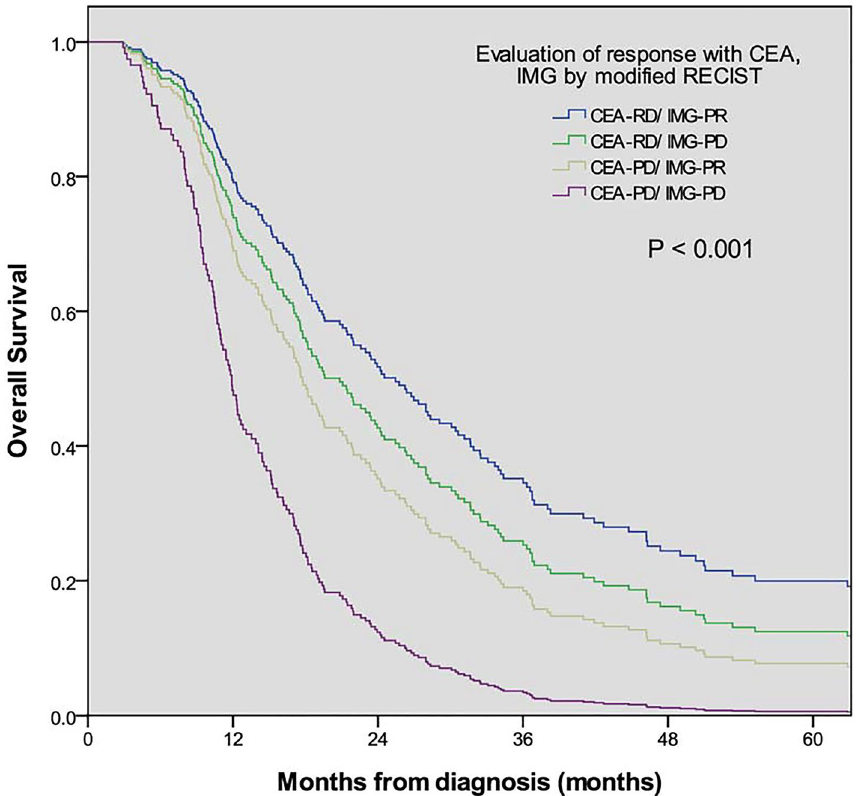
Figure 1. The survival curve between consistent and inconsistent results of CEA change and image findings. The OS in the CEA-RD/IMG-PR, CEA-RD/IMG-PD, CEA-PD/IMG-PR and CEA-PD/IMG-PD groups were 27.3 ± 6.6, 18.2 ± 4.8, 16.2 ± 3.8 and 10.7 ± 2.4 months, respectively and the differences were significant ( P <